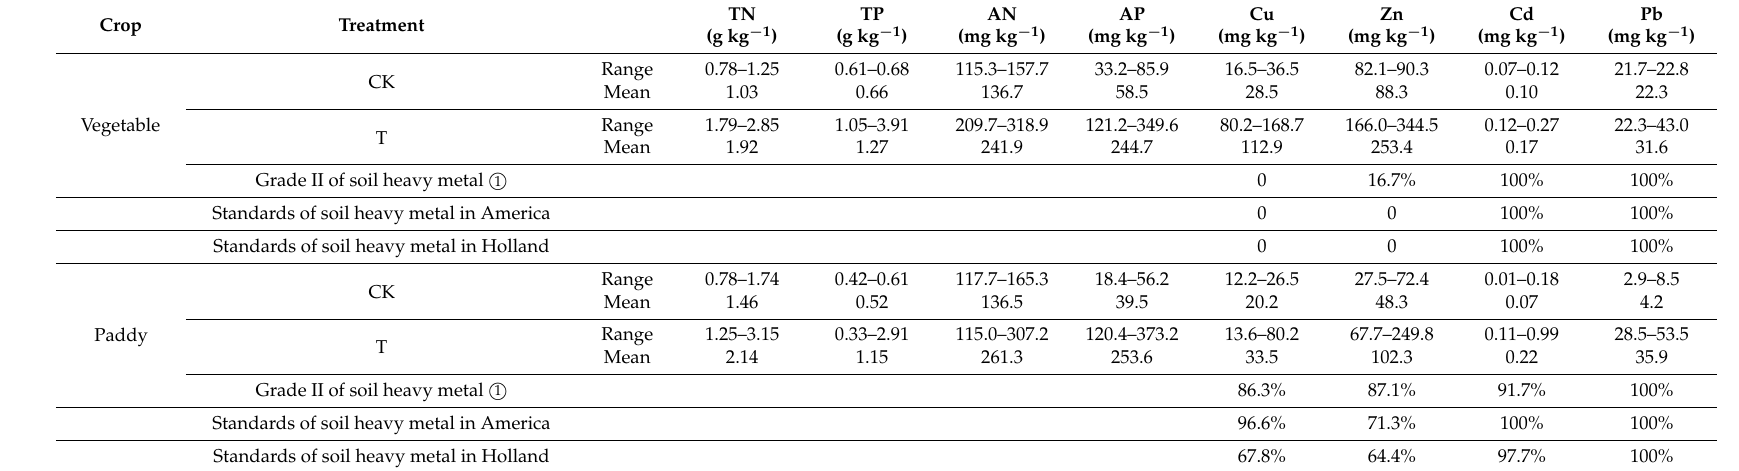
Table 7. Contents of nutrients and heavy metals in soils in the vicinity of sample pig